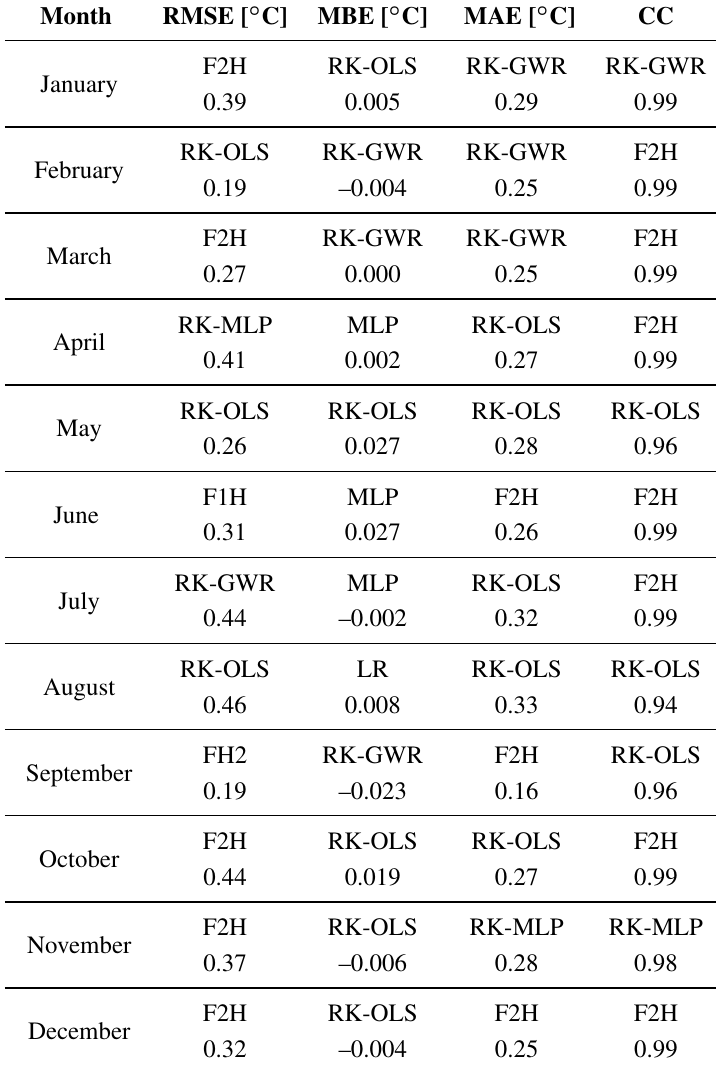
Table 3. Results of monthly analysis; each box reports the interpolation model leading to the best result for each index, and the corresponding value of the